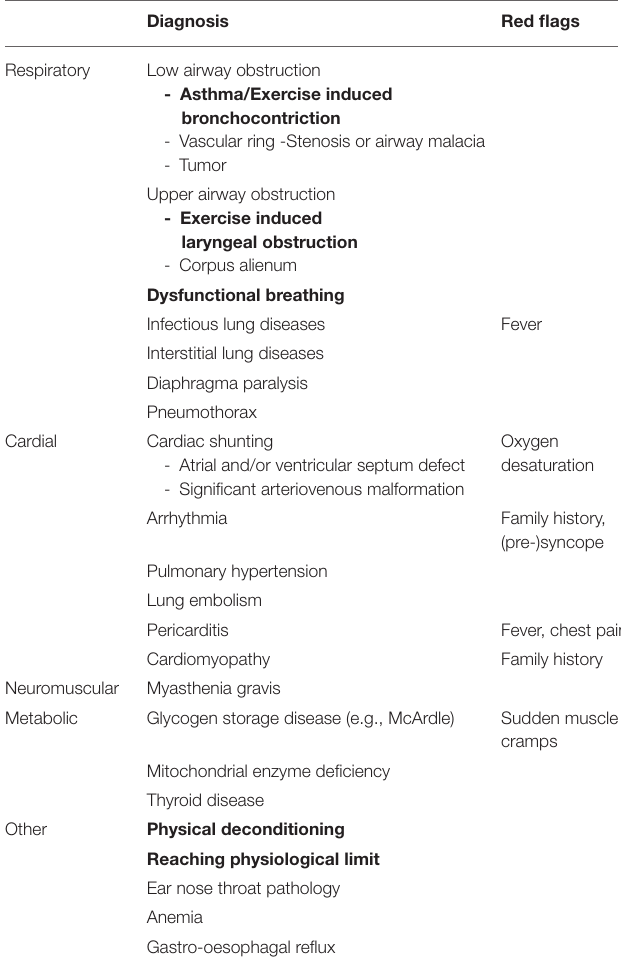
TABLE 1 | Common (bold) and rare causes of exertional dyspnea in children, with corresponding red flag signs and symptoms. Diagnosis Red